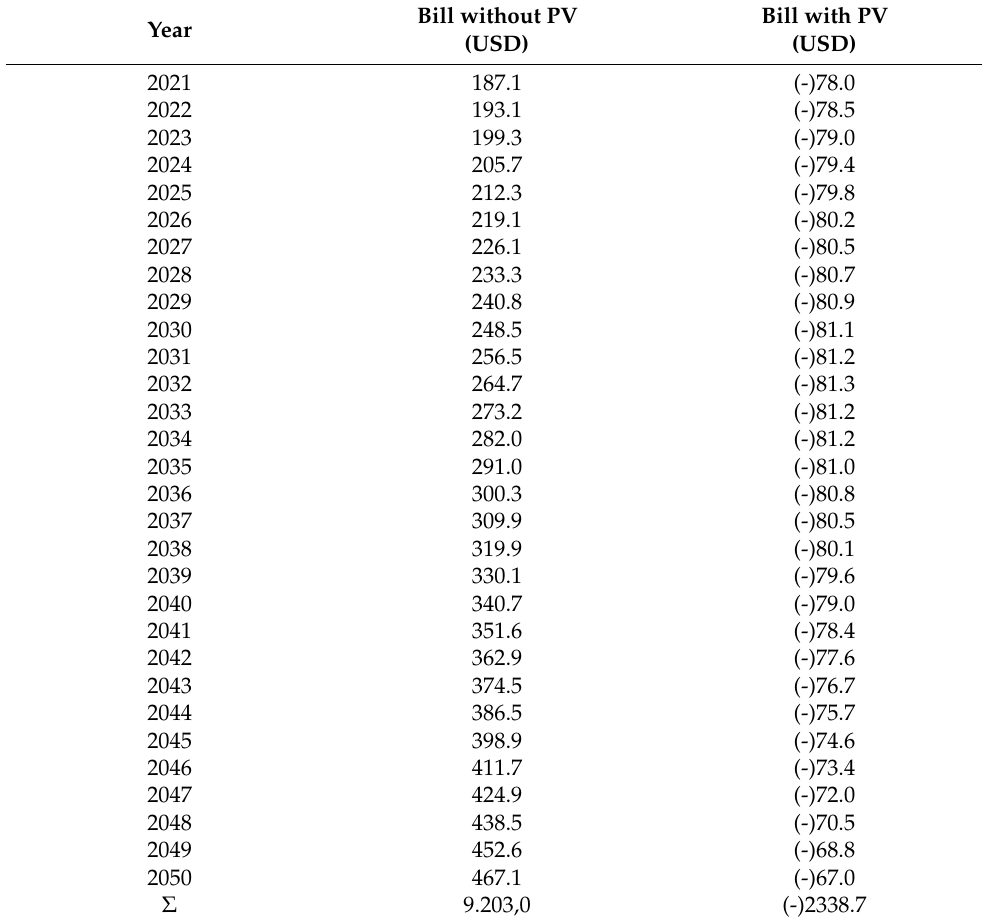
Bill with PV (USD)